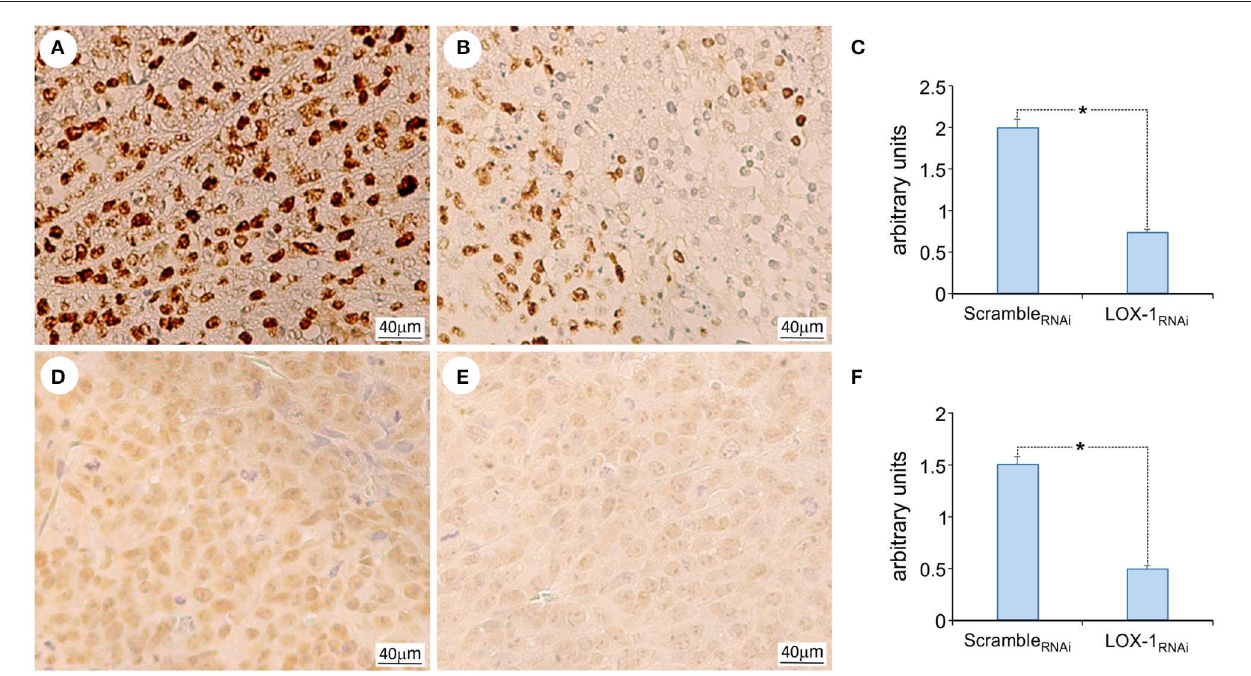
FIGURE 3 | Representative images of the immunohistochemical analysis of Ki 67 and acetyl histone H4 expression. Ki 67 expression in scramble RNAi (A) and LOX-1 RNAi (B) xenograft tumors, and acetyl histone H4 in scramble RNAi (D) and LOX-1 RNAi (E) xenograft tumors. Scale bar 40 µ m. Graphs show the significant decrease of Ki 67 expression (C) and acetyl histone H4 expression (F) in LOX-1 RNAi respect to scramble RNAi tumors (* P <